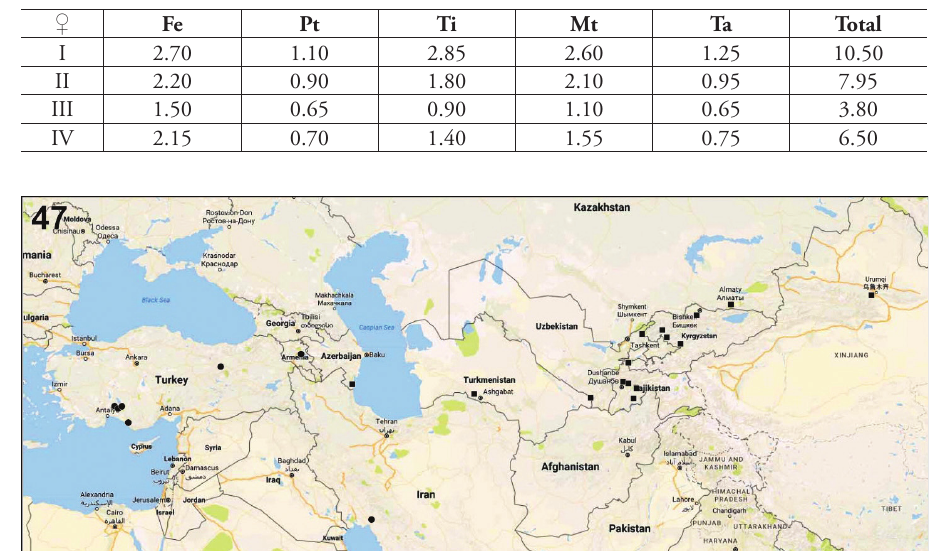
Table 2. Leg measurements of Metellina kirgisica .